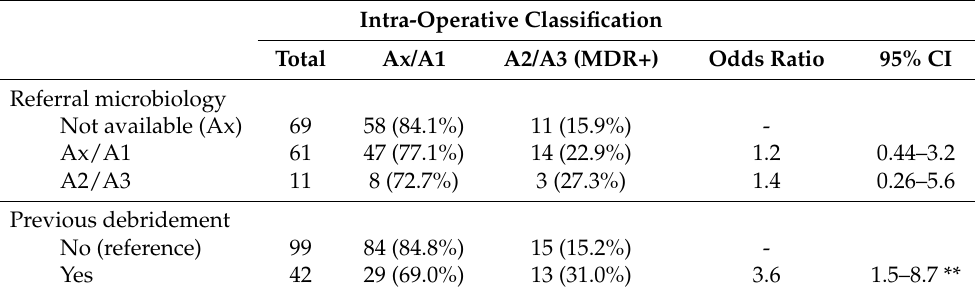
Table 3. Results from multivariate logistic regression assessing MDR+ isolates (A2/A3) versus non- MDR isolates (Ax/A1) during intra-operative sampling. Previous bone debridement of osteomyelitis increased odds of A2/A3 isolate at intra-operative sampling by 3.6 (1.5–8.7), ** p <